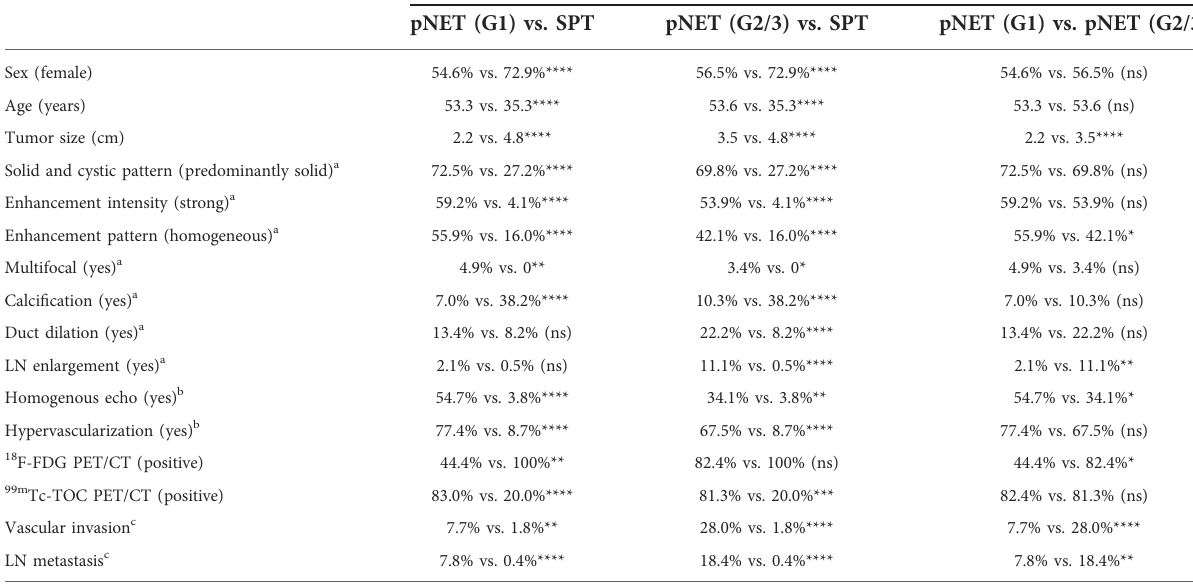
TABLE 7 Comparison of SPT with different grade pNET.